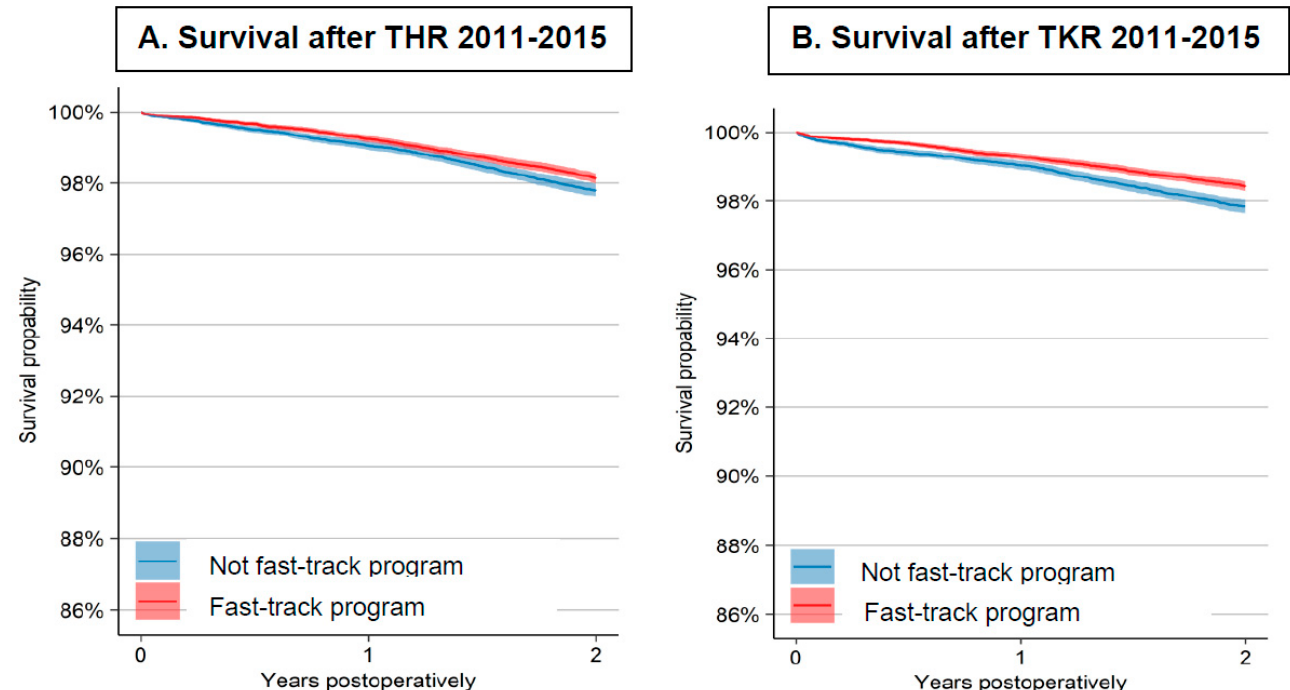
Figure 4. Kaplan–Meier curves of survival within 2 years after THR and TKR. Y-axis truncated in the diagram. A . Survival after THR 2011–2015; B . Survival after TKR 2011–2015.